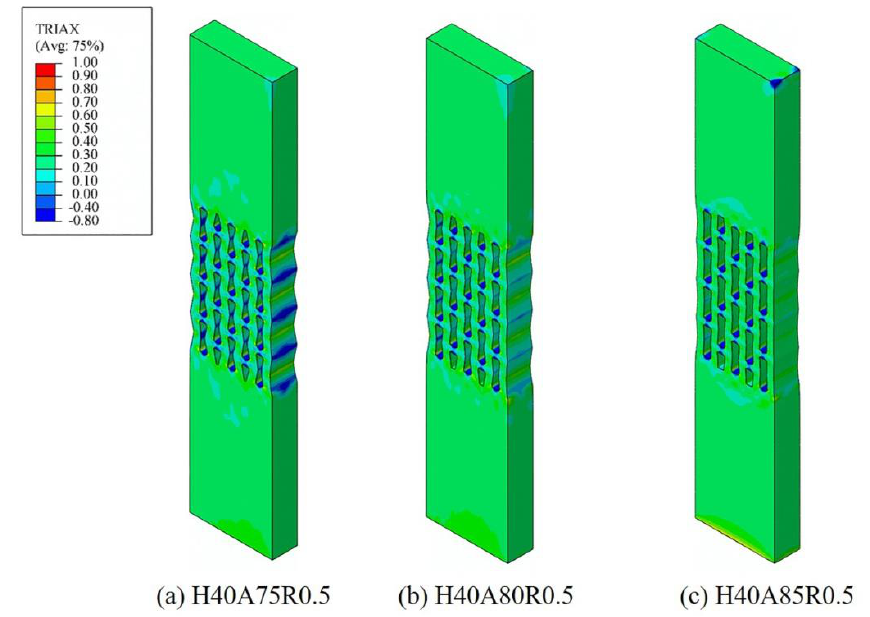
Figure 14. Effect of concave angle on load–displacement curves.